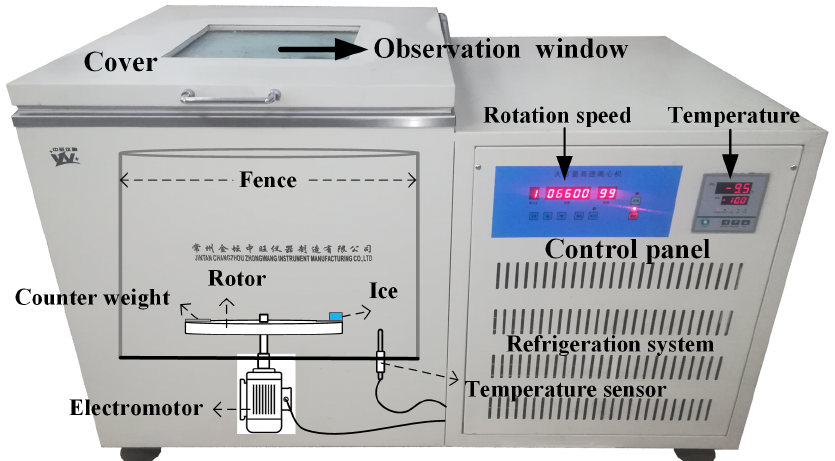
Figure 2. Photograph of the refrigerated centrifuge. Rotor and electromotor are inside. All ice adhesion strength tests were performed inside this apparatus.